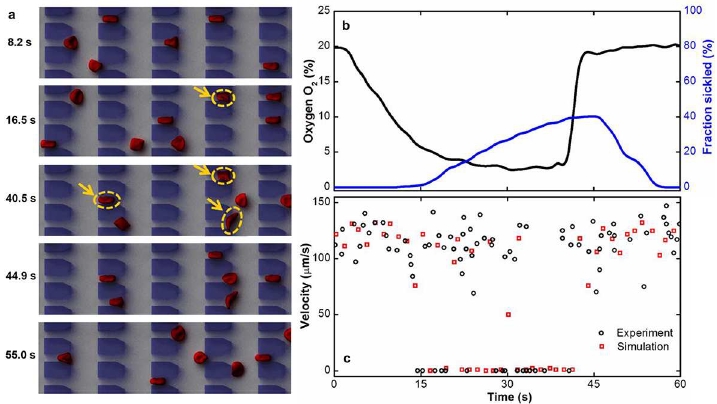
Fig 2. Dynamic behavior of individual sickle cells in response to changes in oxygen concentration. (a) Simulations of time sequenceof RBCs flowingthrough capillary-inspiredmicrochannel under transient hypoxia.The RBCs flow from right to left. Arrows indicatethe trapped sickle cells at the microgates. (b) A representative profile of the sickled fraction under transient hypoxiain DPD simulation. In this case, the sickled fraction is changedfrom 0.0% to 20.2% by loweringthe O 2 concentration from 20% (Oxy state) to less than 5% (DeOxy state). (c) Representative velocity profiles of individual sickle cells obtainedthrough experimental measurement (red circles) and numerical simulations (black